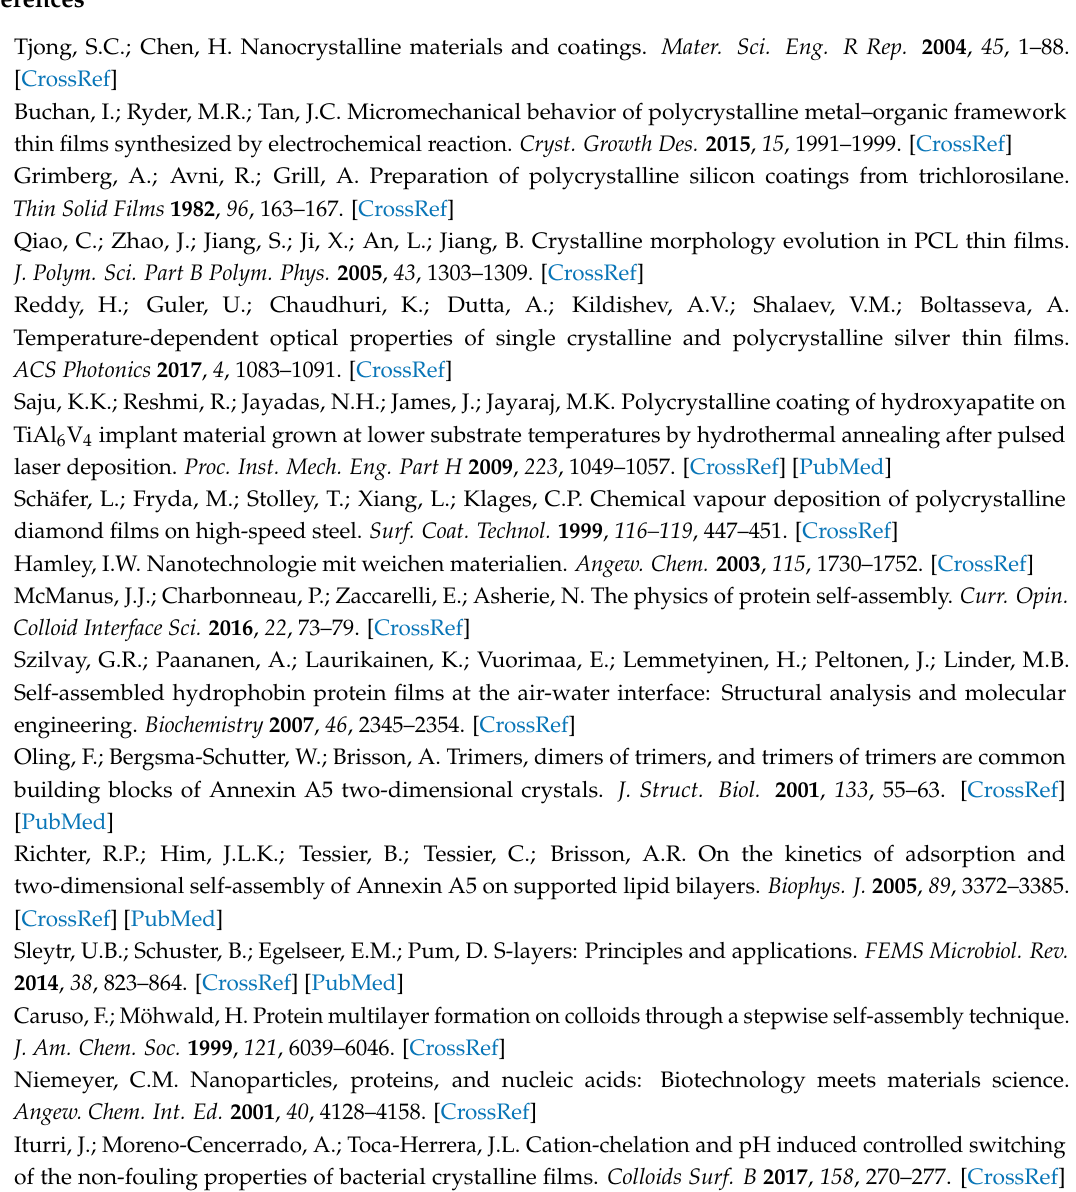
Figure S1: Representative QCMD experiments monitoring the in situ frequency (top) and dissipation (bottom) factor time evolution at stopped-flow conditions, after a one-shot protein injection (300 µ L/min, 90 s). Each color represents the respective SbpA concentrations employed: 0.8, 0.2, 0.08, and 0.04 µ M which correspond to 100, 25, 10, and 5 (in µ g/mL). Adsorption values from 50 µ g/mL SbpA are omitted because of better visualization purposes, since they almost overlap those from 100 µ